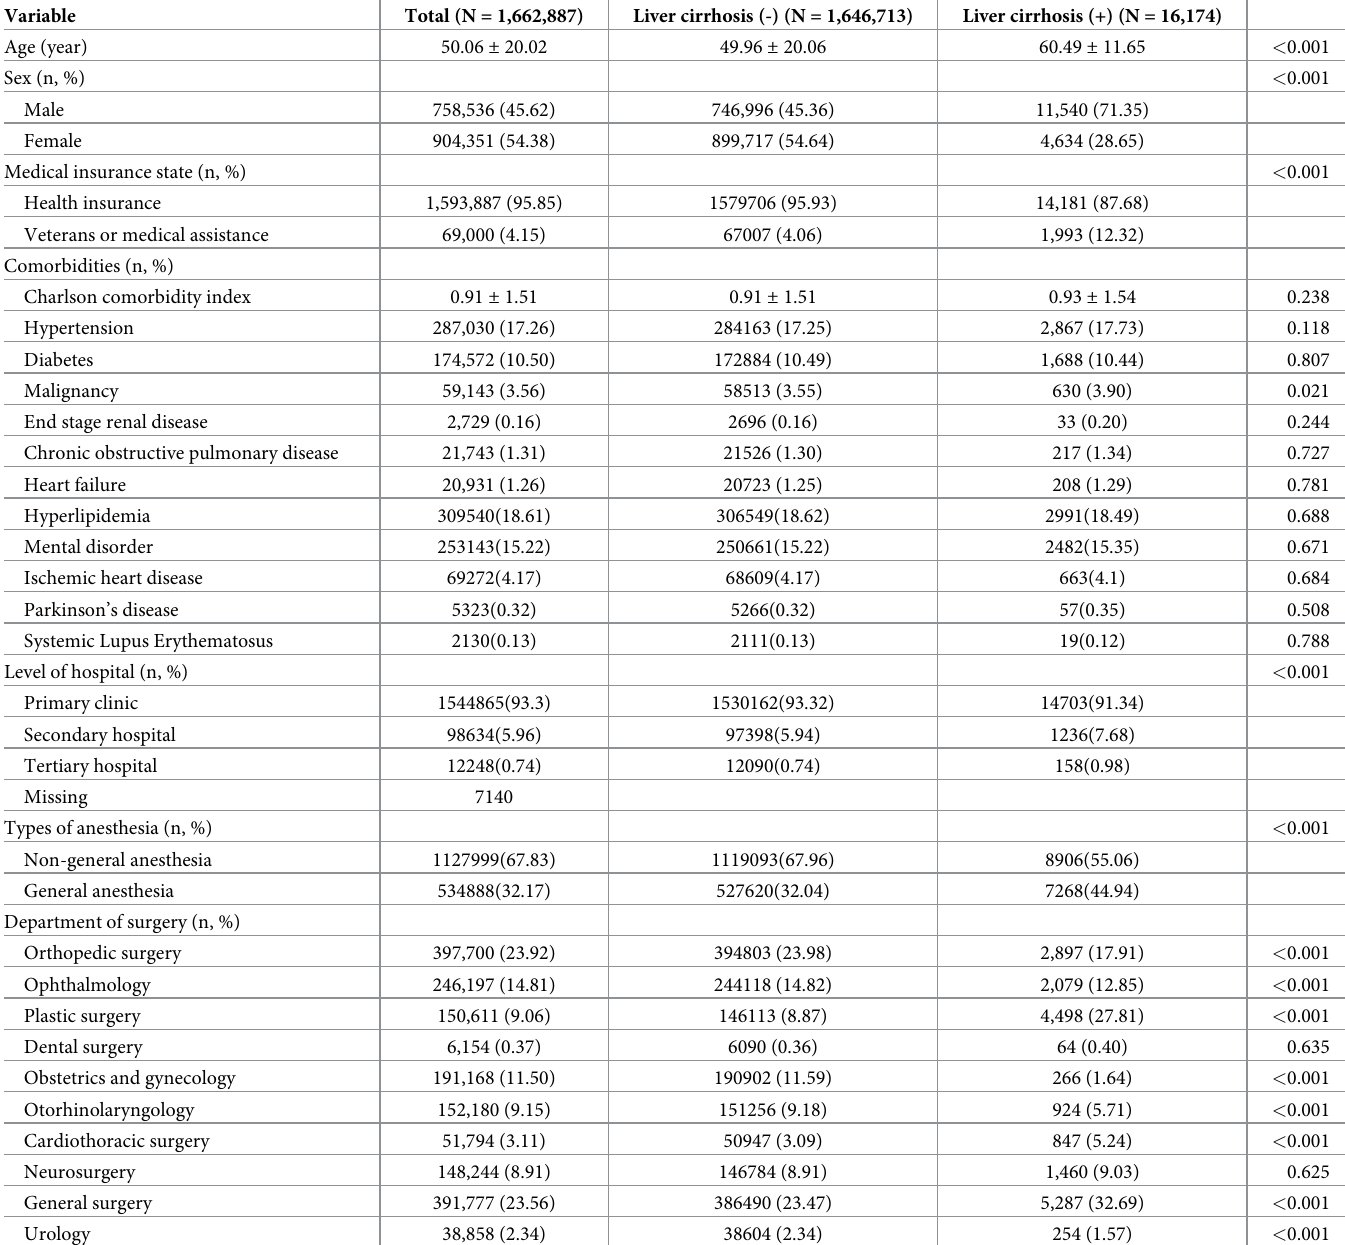
Table 1. Baseline characteristics of the